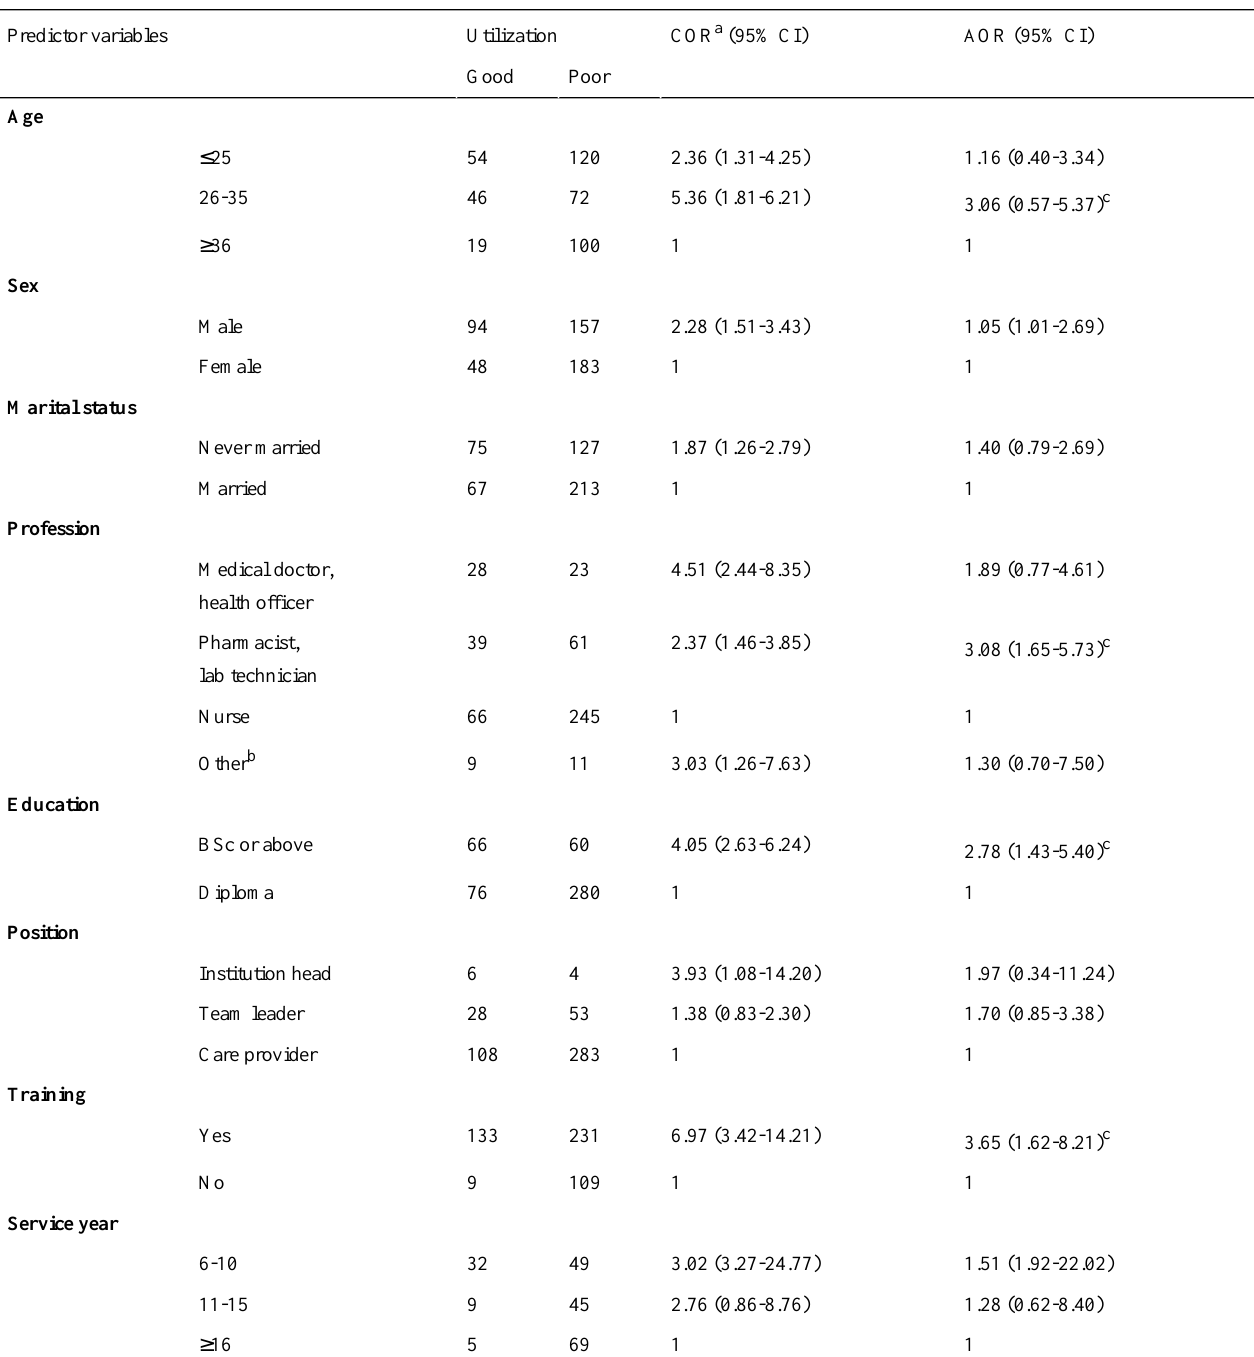
Table 2. Factors associated with computer utilization among health